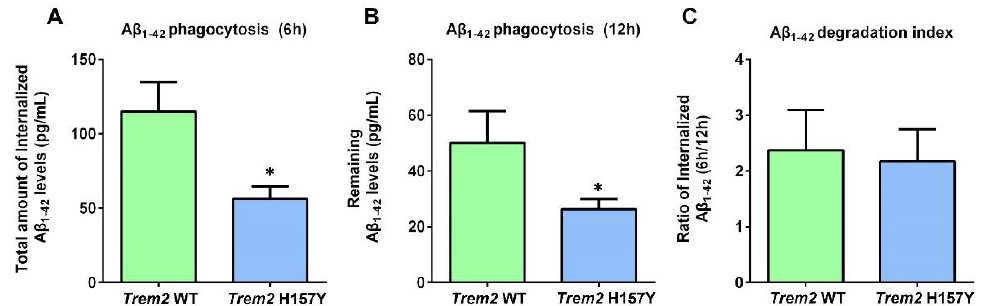
Figure 1. The Trem2 H157Y variant inhibits microglial phagocytosis of Aβ. An in vitro assay was employed to evaluate microglial Aβ 1–42 phagocytosis and degradation. ( A ) WT Trem2 BV2 microglia or BV2 microglia with the Trem2 H157Y variant were incubated with 5 μM Aβ 1–42 for 6 h. The amount of internalized Aβ 1–42 was measured by ELISA (t = 6 h). ( B ) Later, the Aβ 1–42 left in the medium was washed out, and WT Trem2 BV2 microglia or BV2 microglia with the Trem2 H157Y variant were maintained for an additional 6 h to allow for Aβ 1–42 degradation. The intracellular Aβ 1–42 levels were assessed by ELISA again (t = 12 h). ( C ) The index of Aβ 1–42 degradation was expressed as the ratio of the total amount of internalized Aβ 1–42 (t = 6 h) to remaining Aβ 1–42 (t = 12 h). A higher degradation index indicates a better capacity for degradation of Aβ 1–42 . Data were analyzed by one-way ANOVA followed by Tukey’s post hoc test. Columns represent means ± SDs (n = 3, performed in triplicates), * p < 0.05 versus WT Trem2 BV2 microglia.